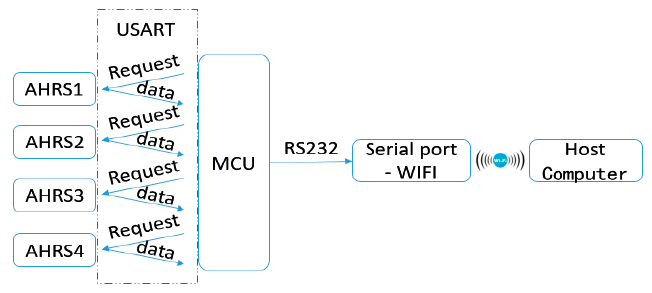
Figure 4. The configuration of the proposed multi-sensor system.